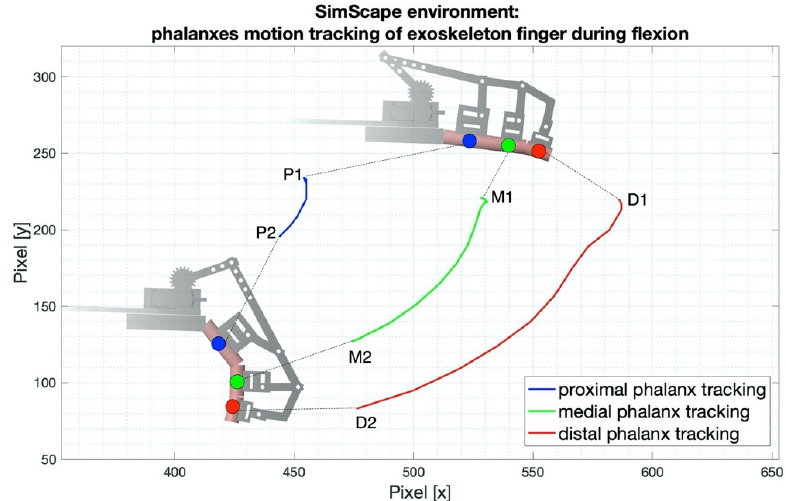
Figure 11. Trajectories described by each phalanx of the index finger (depicted in different colors) of the hand exoskeleton during flexion movement in the simulation environment (SimScape).